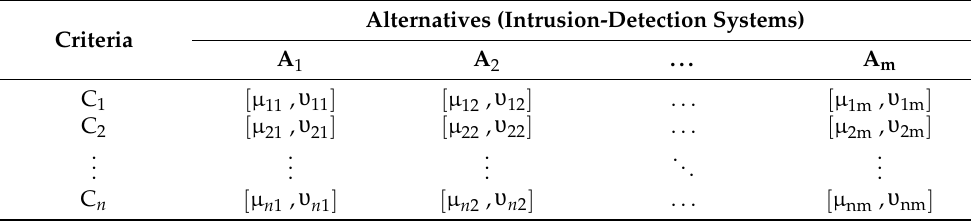
Table 4. Combined evaluation matrix for alternatives in terms of the criteria based on q-ROFN.